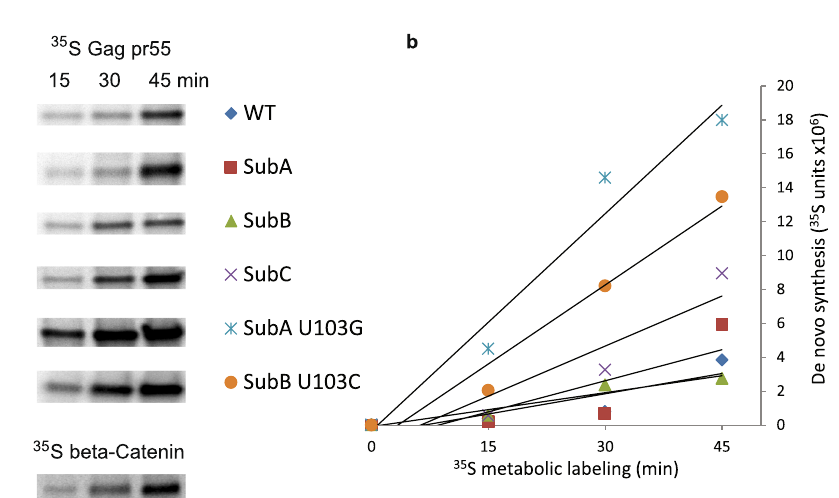
Figure 2. The rate of de novo Gag synthesis from dimer-prone 5 ′ UTR is similar to some, but not all, monomer 5 ′ UTRs. A representative kinetic experiment using the metabolic labeling approach described in Figure S1 is presented. Rate of gag RNA translation was similar between HIV NL4-3 WT and SubC dimer-prone 5 ′ UTRs and monomer-prone SubA and SubB, yet significantly increased by U103 substitutions (SubA U103G and SubB U103C) at PolyA stem. ( a ) SDS-PAGE and phosphorimage of 35 S-Gag precursor (pr55 Gag) and beta-Catenin loading control. Full-length gels are provided in Figure S2. ( b ) Quantification of 35 S-Gag polypeptides measured by ImageQuant in this representative experiment with trendlines reflecting differences in translation